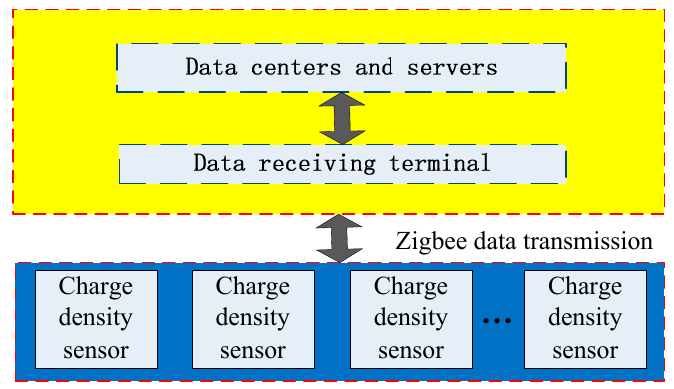
Figure 2. Structure of the distributed measurement system.